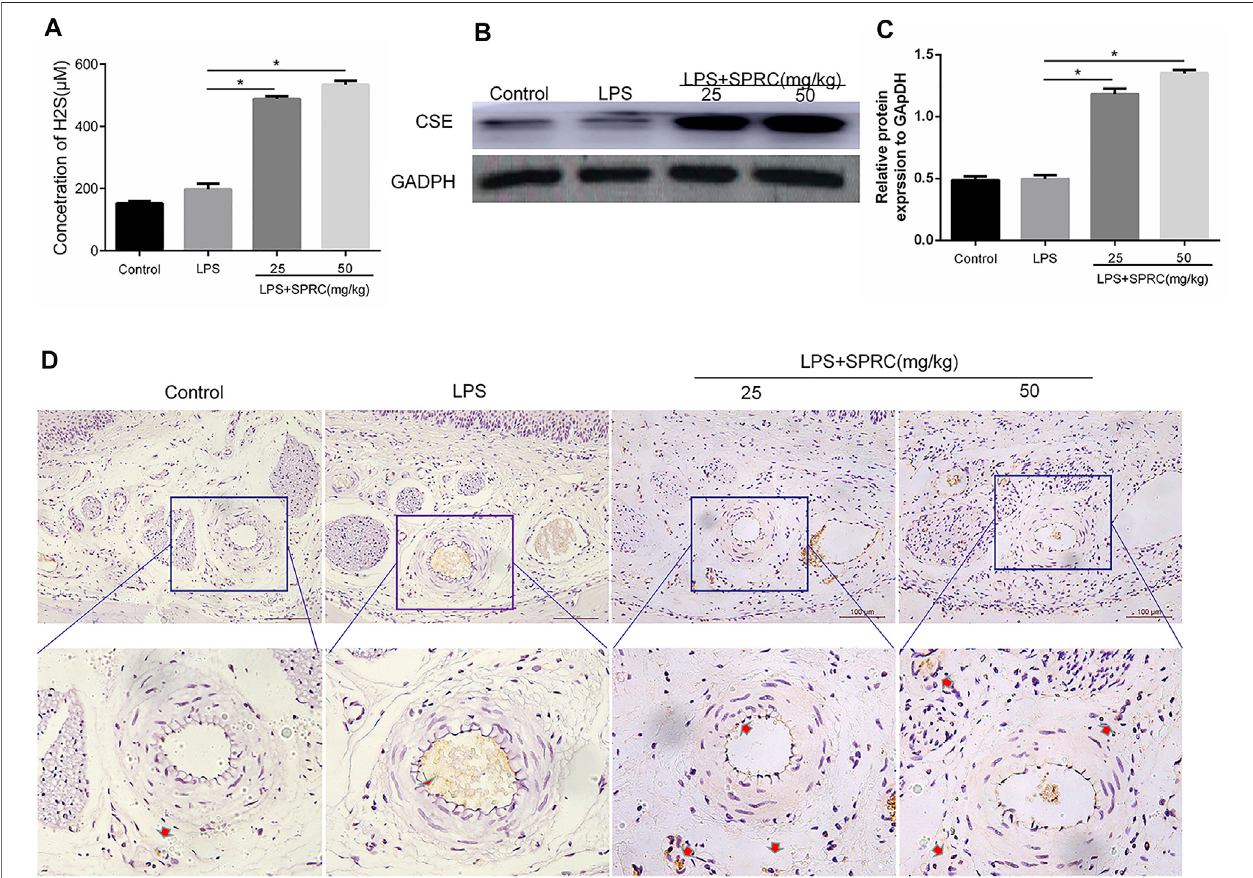
FIGURE 3| Plasma H2S concentration and CSE expression level in gingival tissue. (A) The content of H2S in peripheral blood after SPRC applied for 3 weeks. (B) WesternblotdetectionofCSEenzymeexpressionlevelingingivaltissue. (C) Quantitativeanalysisofwesternblotresults. (D) Immunohistochemicallocalizationdetection of CSE enzyme expression in lingual gingival (perivascular tissue), above ( × 200 magni fi cation scale bar (cid:1) 100 μ m), lower ( × 400 magni fi cation) (Data are shown as the means ± SD from 4 animals, * p < 0.05 vs. LPS group).